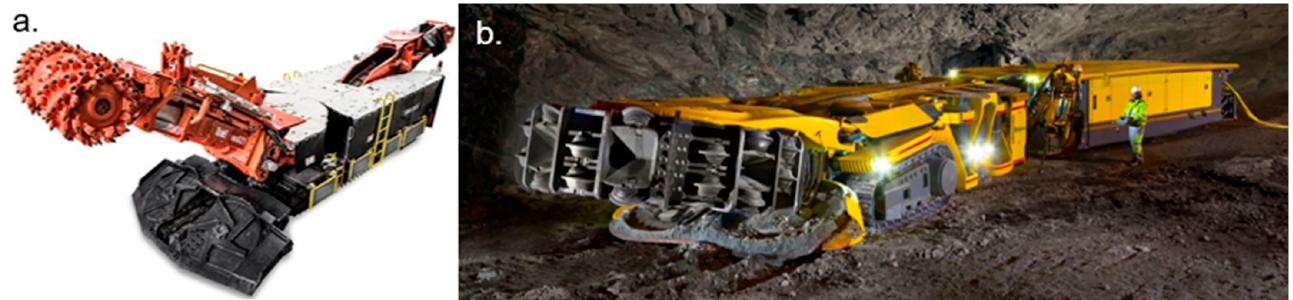
Figure 2. Examples of mining machines with conical picks and discs [17]: ( a ). ICUTROC road header produced by Sandvik and ( b ). Epiroc Mobile Miner 22H.